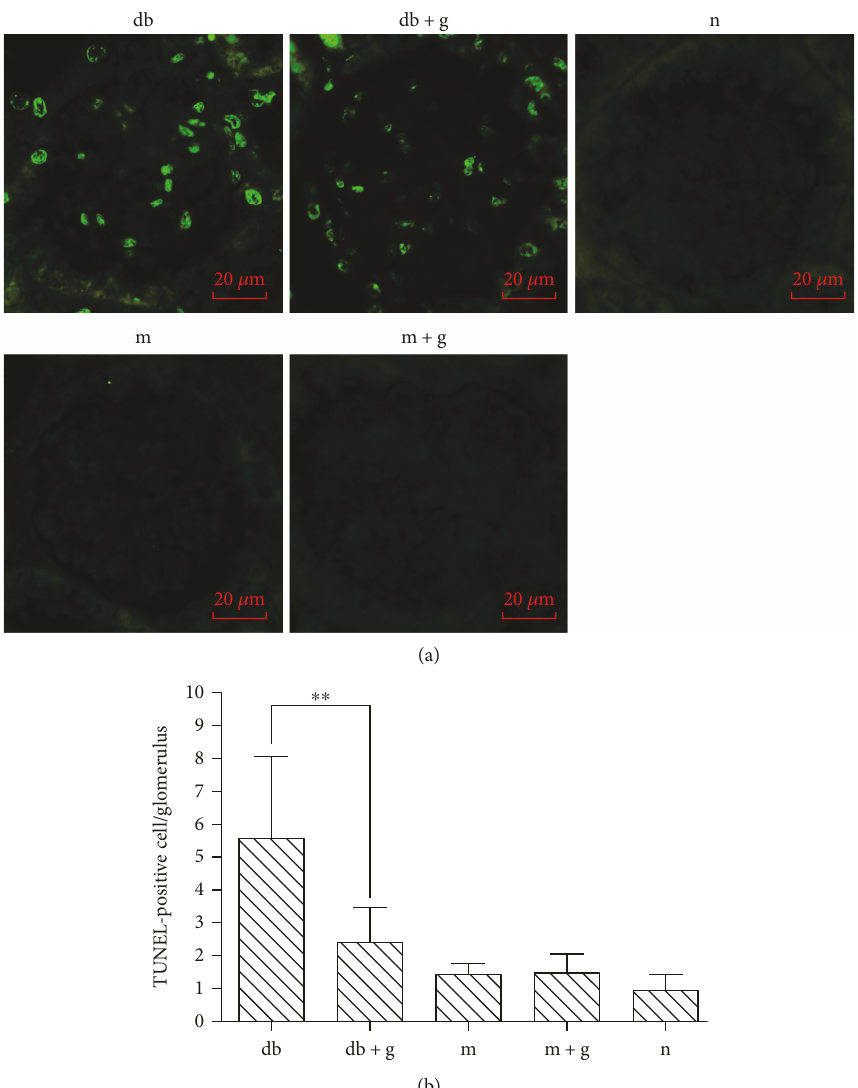
Figure 3: E ff ect of GA on apoptosis of cells in the renal cortex of db/db mice. Representative micrographs of TUNEL staining in the renal cortex (a). The same data are shown as a graph (b). The graph shows the number of TUNEL-positive cells that were detected in the glomerulus. Original magni fi cation, × 400. ∗∗ p < 0 001 compared with the control